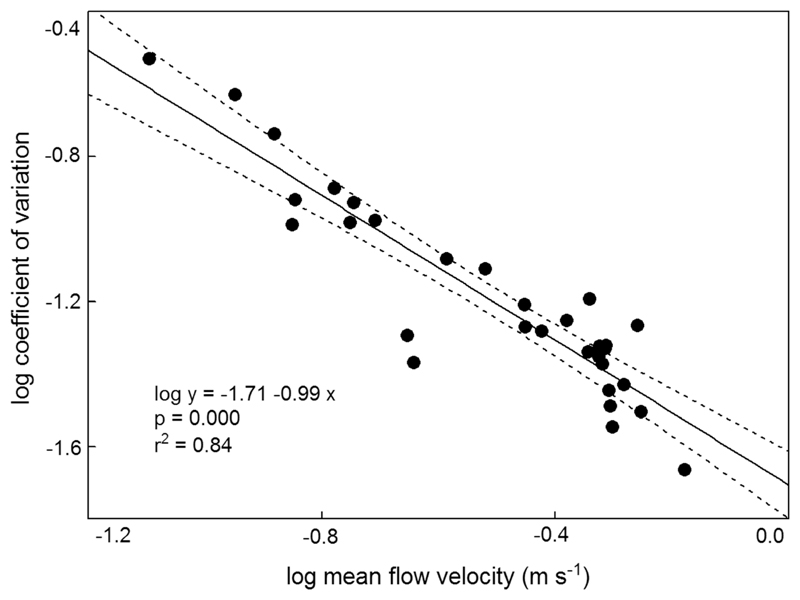
Relationship between mean flow velocity (log m s−1) and coefficient of variation (log) for spatio-temporally filtered velocity data (intervals = 1 s; 31 measuring runs); showing regression line and 95% CL confidence bands